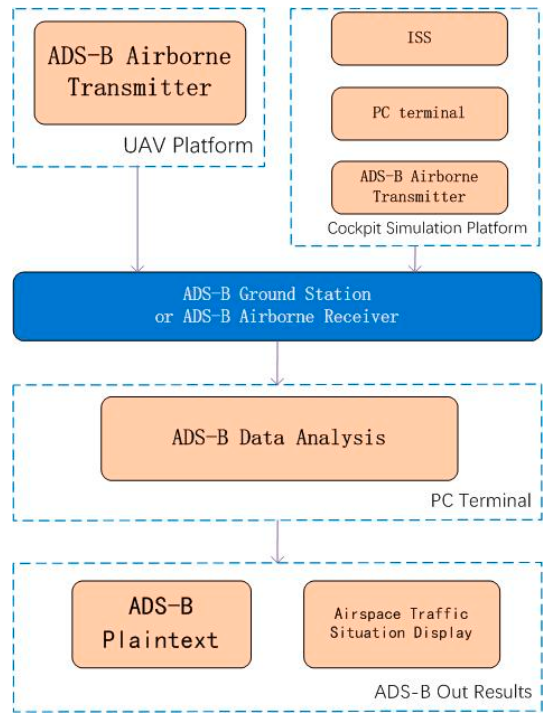
Figure 5. ADS-B Out minimum system design.